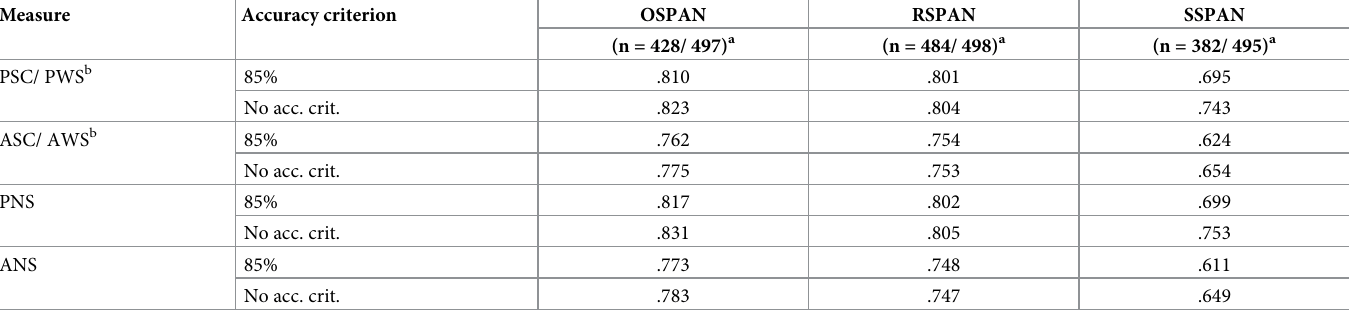
Table 2. Cronbach’s α for six working memory capacity (WMC) scores according to the working memory (WM) span task and accuracy criterion on the processing component of the task.